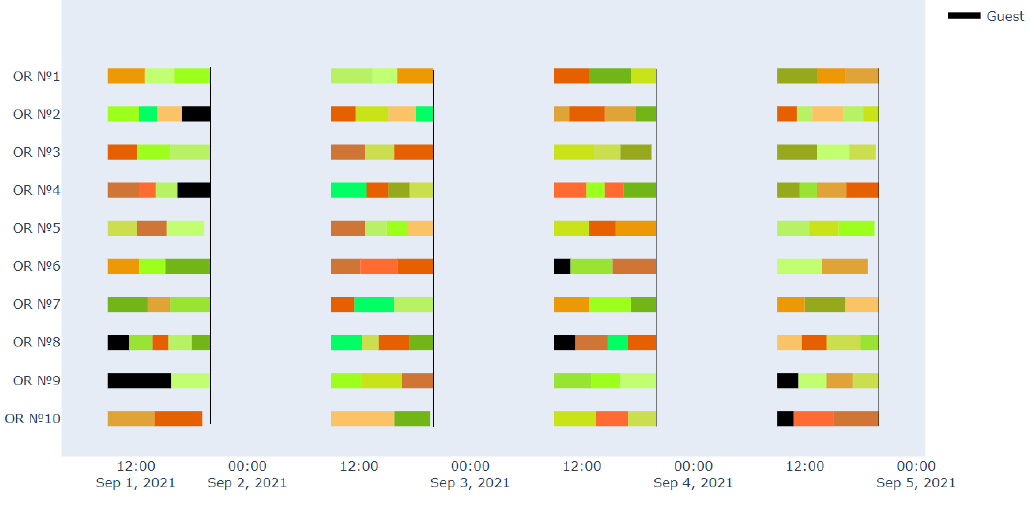
Figure 8. Example of schedule for exact